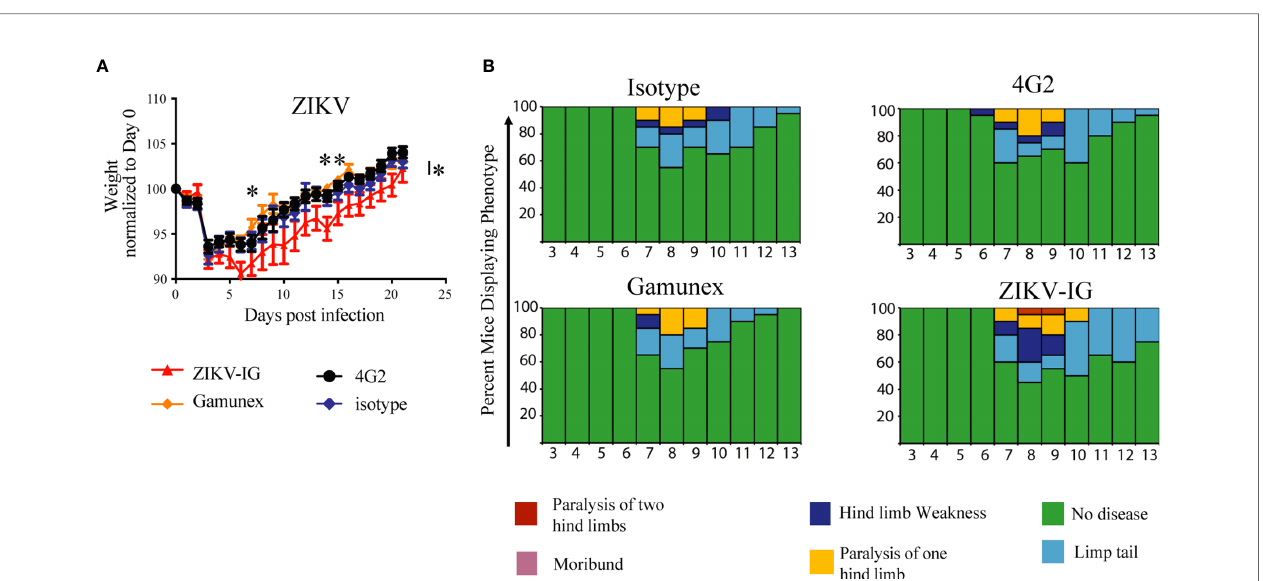
FIGURE 4 | Weight loss, and clinical score of ZIKV-infected Ifnar1-/- mice under ADE conditions. Ifnar -/- mice were transferred passively isotype control (0.020 mg of mouse anti-NP or 2 mg of Gamunex ® ) or enhancing mAbs (0.020 mg of anti-E (4G2) or 0.050 mg of ZIKV-IG) and then infected a day later with 10 5 FFU of ZIKV (strain PRVABC59) via an intravenous route. Weight change (A) and clinical score (B) were monitored. The data re fl ects 20 mice per group, consisting of 10 males and 10 females. Mice were evaluated for signs of disease daily and graphed on each day as a percentage of mice displaying that disease indicator. Signs of disease range from no apparent disease, limp tail, hind limb weakness, hind limb paralysis, complete paralysis to death. Body weight comparison as single days was completed by Dunnett ’ s test, comparisons of weight over time was completed by 2-way ANOVA, while number of disease days was determined by Fisher exact test. Statistical differences are denoted by a star *p < 0.05, **p <